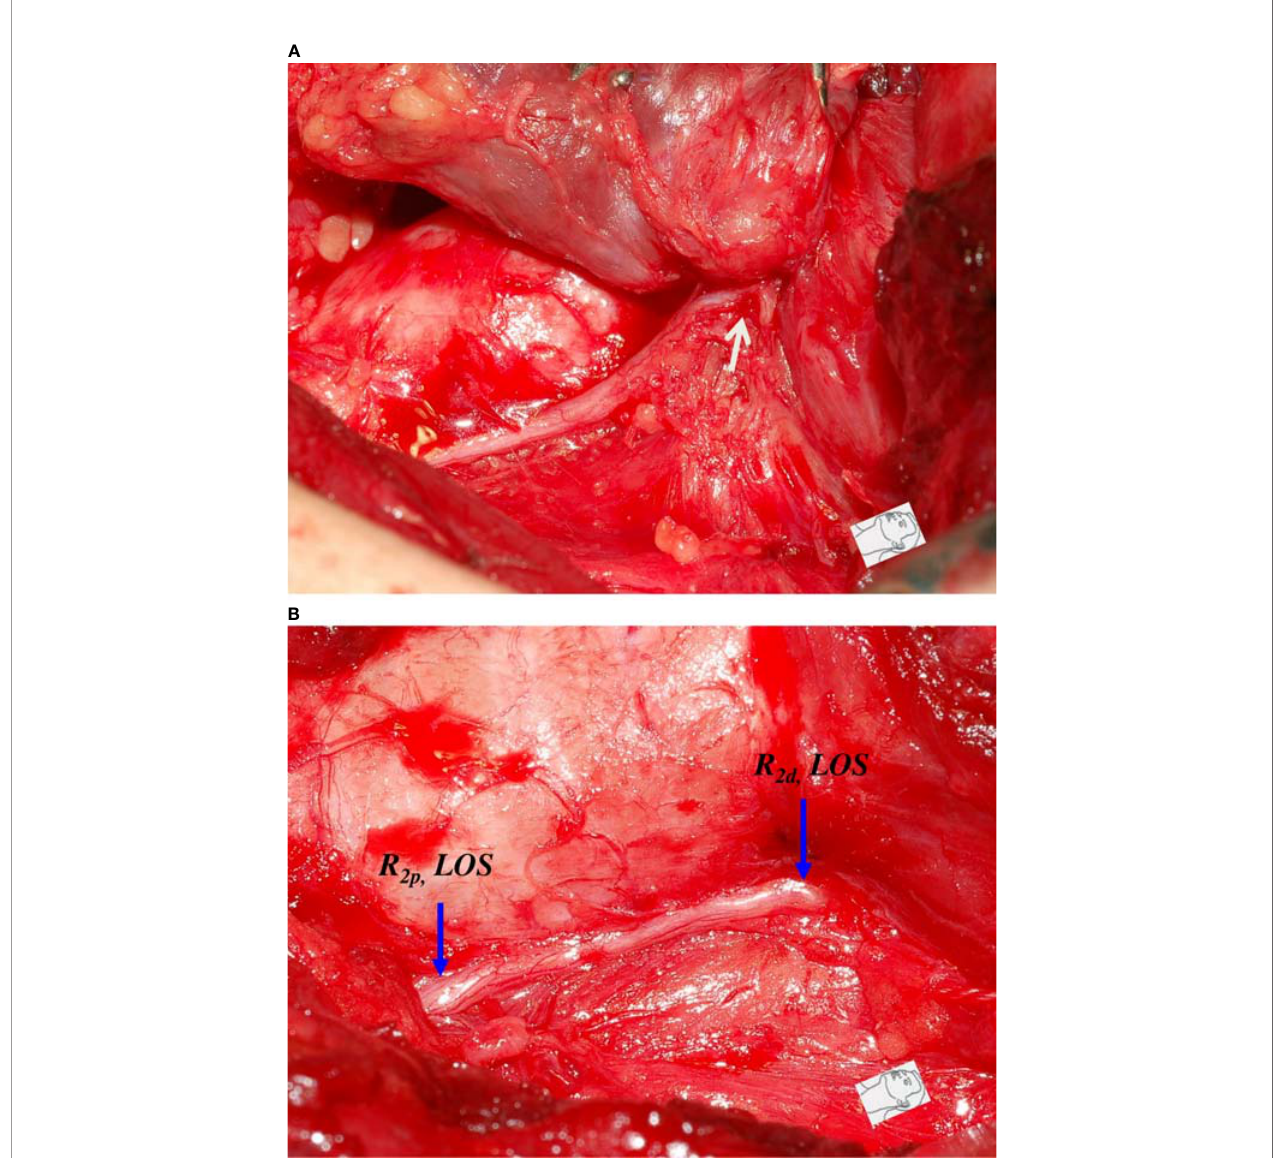
FIGURE 3 | A case of type 2 complete LOS. (A) The RLN was stretched upward (white arrow) at the region of Berry ’ s ligament during medial thyroid traction. (B) After complete RLN dissection, both R 2p and R 2d signals showed complete LOS and no injured point was found on the exposed RLN. This was a type 2 LOS and it developed temporary vocal cord